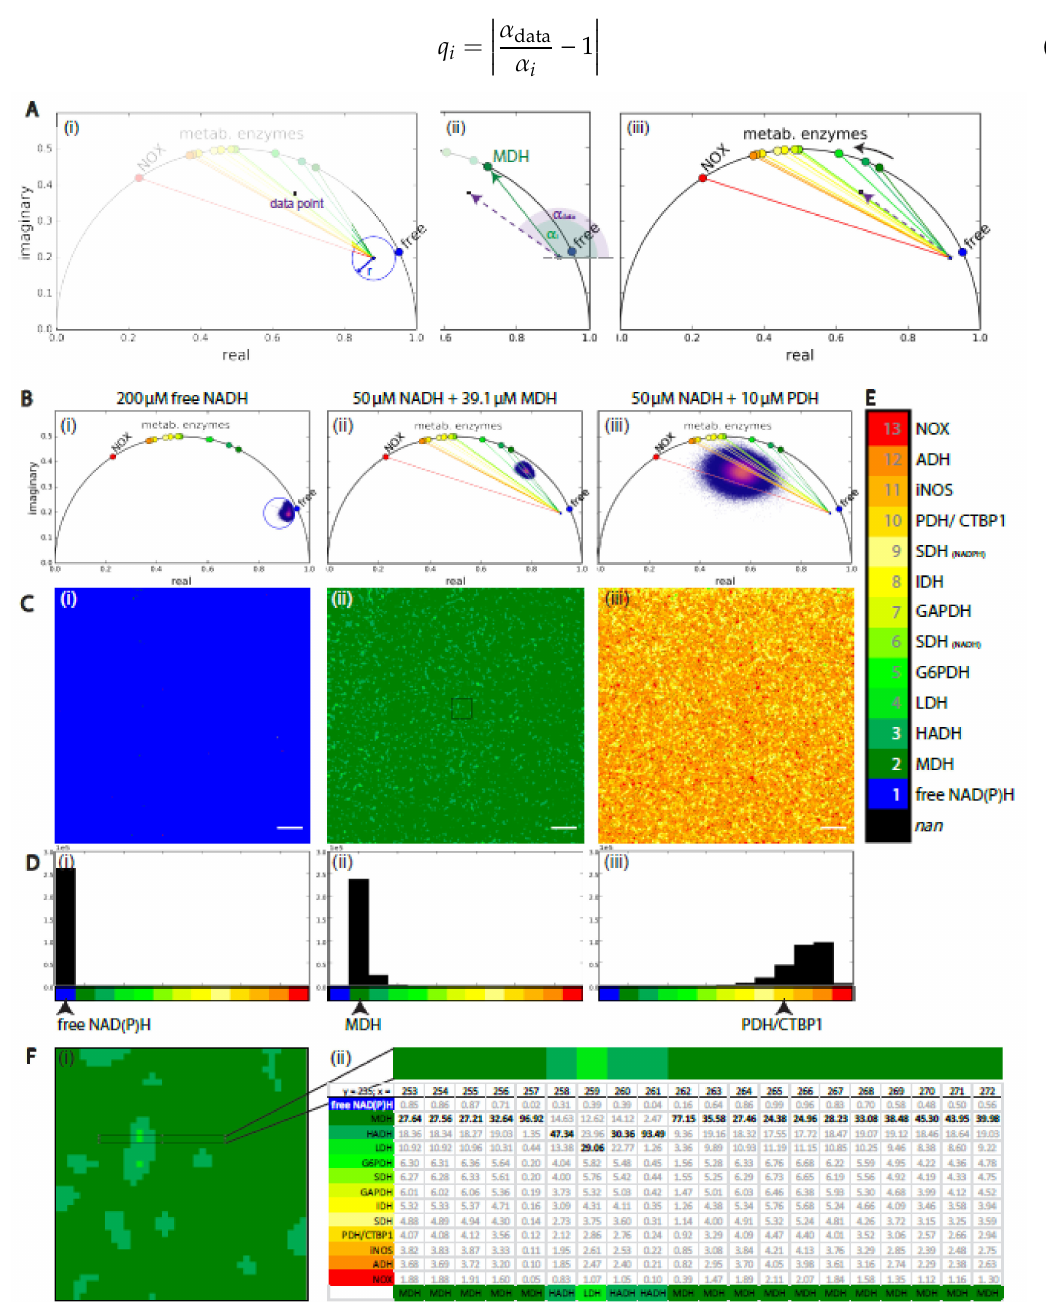
Figure 3. Validating the systematic framework of NAD(P)H-FLIM data analysis. ( A ) Strategy for assigning a data point (violet) to free or enzyme-bound NAD(P)H. ( Ai ) Inspection whether the data point is within the radius r , which indicates the measured phasor position of free NAD(P)H. The blue circle describes the experimental area of only free (unbound) NAD(P)H. ( Aii ) If ( Ai ) does not apply, the angles α data and α i ( i = enzyme index) are calculated and compared for every single NAD(P)H-dependent enzyme by equations (Equations (2) and (5)). The data point is assigned to the enzyme for which (Equation (5)) it becomes maximal. The purple dotted arrow describes an experimental trajectory vector of a pixel, whereas the solid green arrow stands for the expected trajectory vector of NADH bound only to MDH (enzyme index 2). The green sector describes the angle α 2 between the x-axis (Re-axis) and the green trajectory vector whereas the purple sector describes the same angle α data calculated from the experimental data (purple trajectory vector). ( Aiii ) Phasor